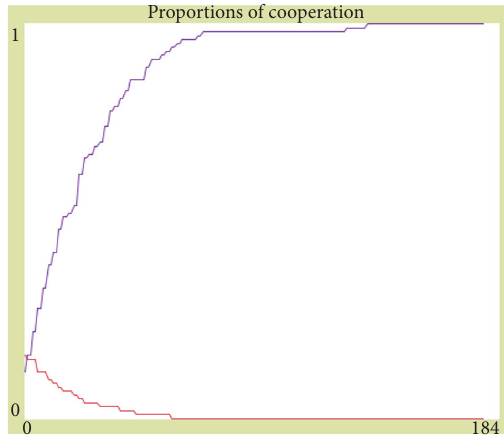
Figure 2: Simulation on evolution of knowledge workers’ CWB.